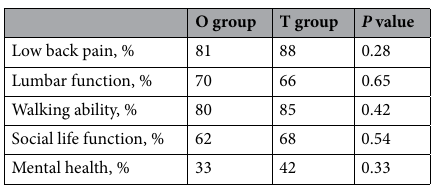
Table 5. Therapeutic effectiveness JOABPEQ. There was no significant difference in therapeutic effectiveness between the two